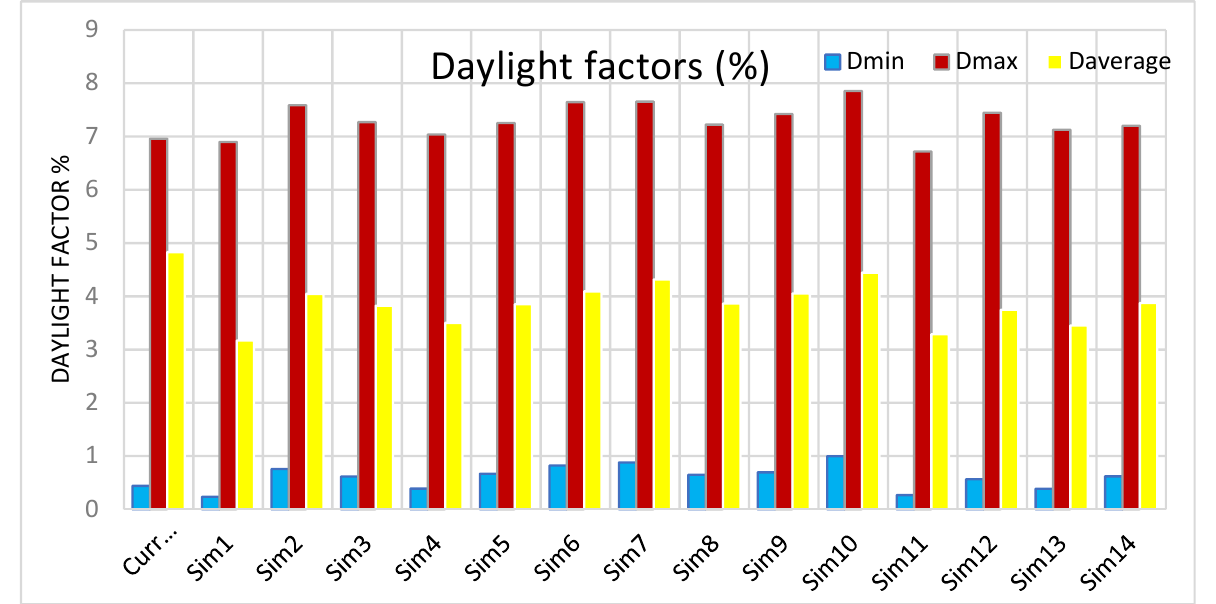
12 of 19 Table 4. Results of calculated DF by simulation program for variants of surface color. Variant of Sur- face Color